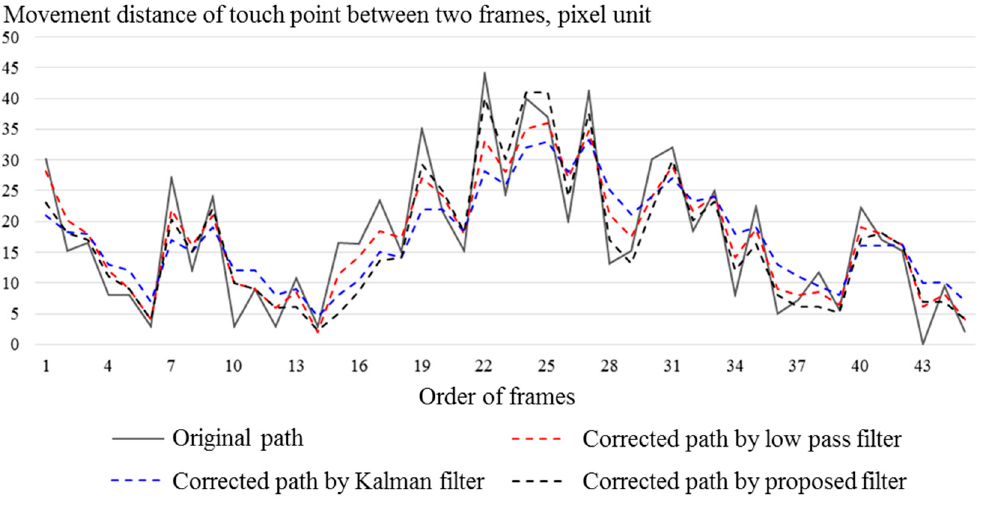
Figure 15. Responses of filters to touch movements.